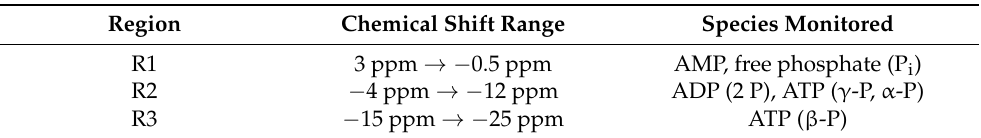
Table 1. Integration regions in 31 P-NMR spectra used to calculate the concentrations of AMP, ADP, ATP and free phosphate (P i